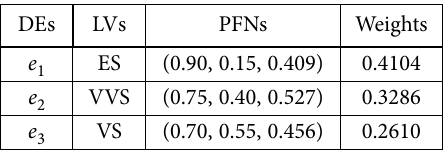
Table 4. Weight of DEs for evaluation the